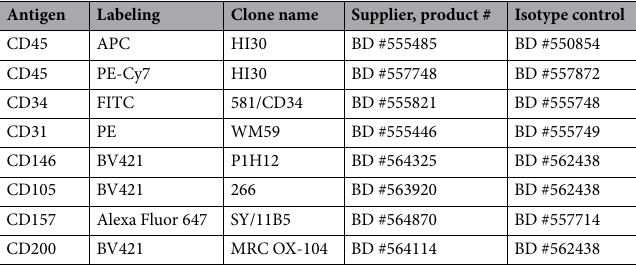
Table 1. List of antibodies used during flow cytometric